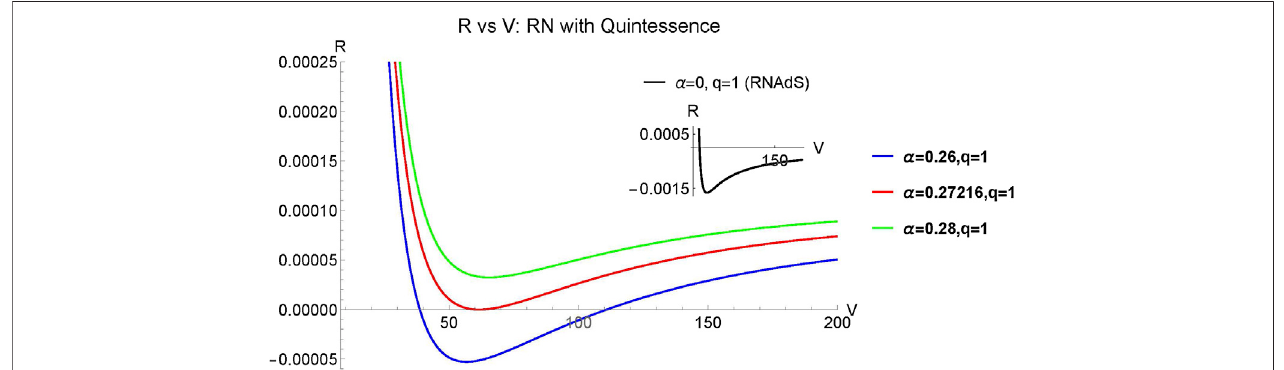
FIGURE 3 | Ruppeiner curvature on the (T,V) plane as a function of V for fi xed T.